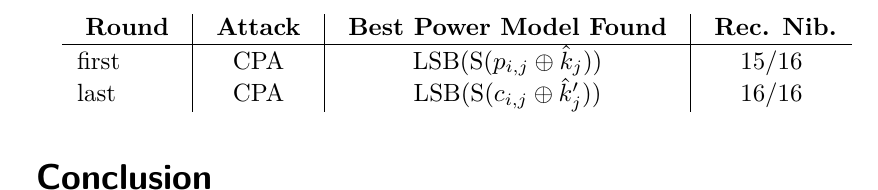
Table 8: Summary of the optimal attack results (among all tested ones) for the static power scenario with a maximum of 500 000